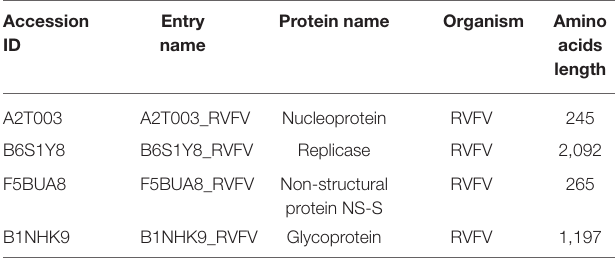
TABLE 1 | Accession information and other details of assessed